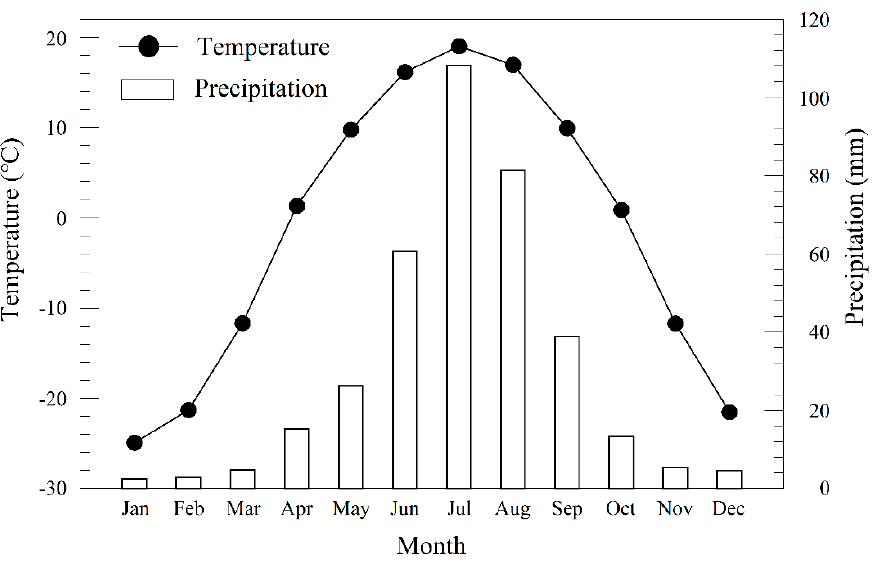
Figure 3. The meteorological data. The monthly mean temperature and mean precipitation from the Climatic Research Unit time series (CRU TS4.01).01 in 0.5° × 0.5° gridded datasets (47.5° N– 49.5° N, 119.0° E–120.5° E, 1951–2013 CE).